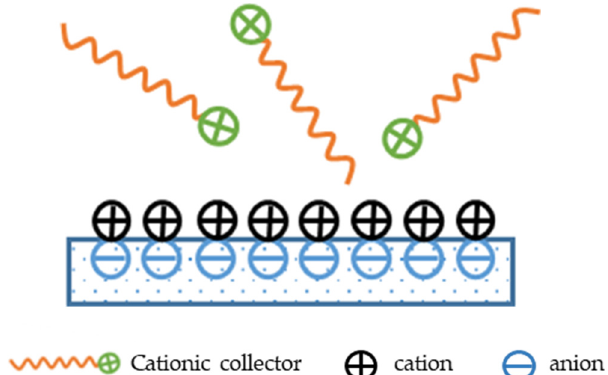
Figure 7. E ff ect of cations on the adsorption of amines on the quartz Figure 7. Effect of cations on the adsorption of amines on the quartz surface.